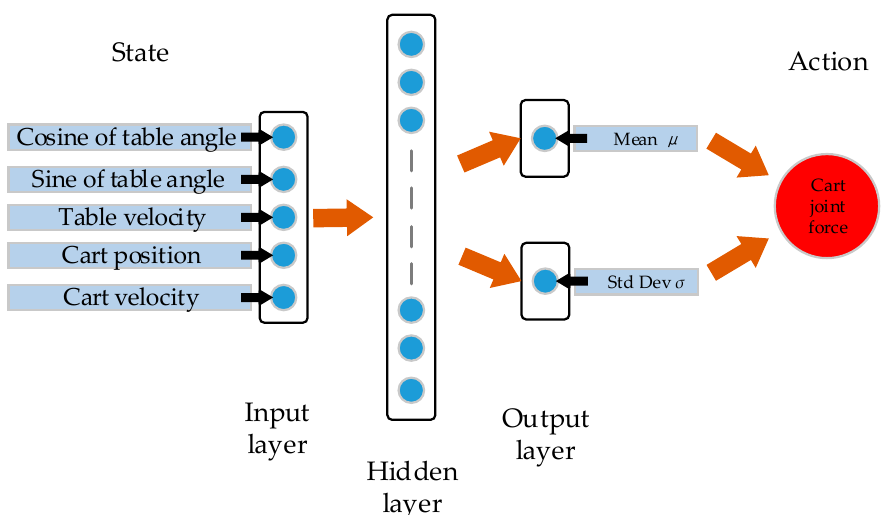
Figure 4. Policy network of the policy gradient (PG) method in cart–table model.